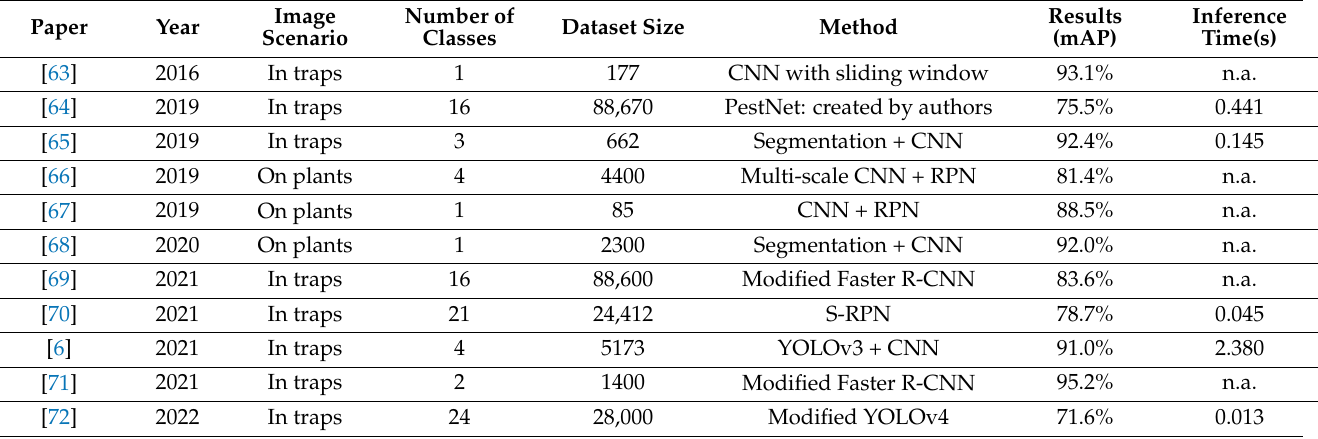
Table 4. Study analysis of detection with combined/adapted